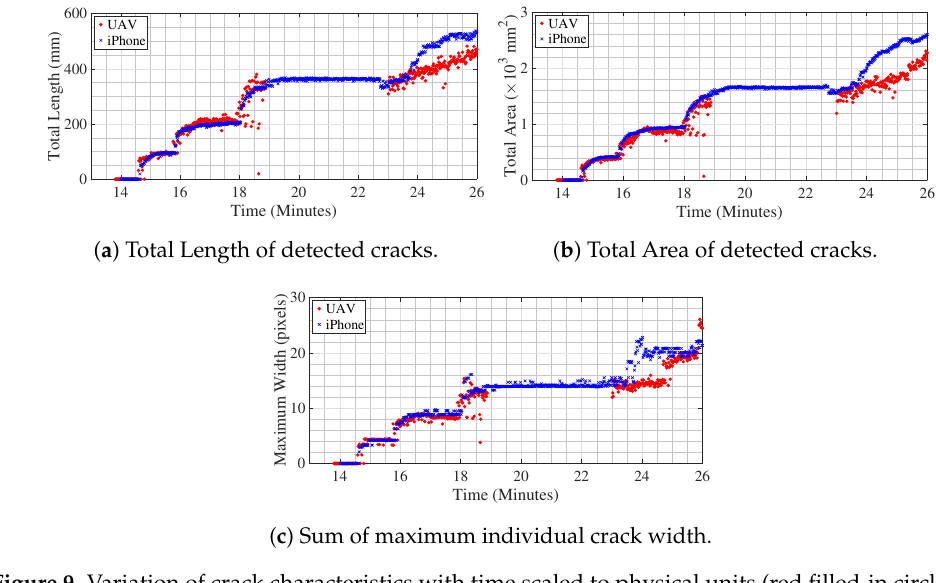
Figure 9. Variation of crack characteristics with time scaled to physical units (red filled-in circles for UAV video, and blue crosses for iPhone